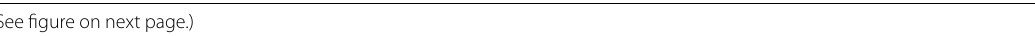
Table 1 Top clustered genes in the PPI networks. The seed genes with the highest density in PP networks are shown GOID Betweenness Closeness centrality Degree GOID Betweenness centrality Normal vs.